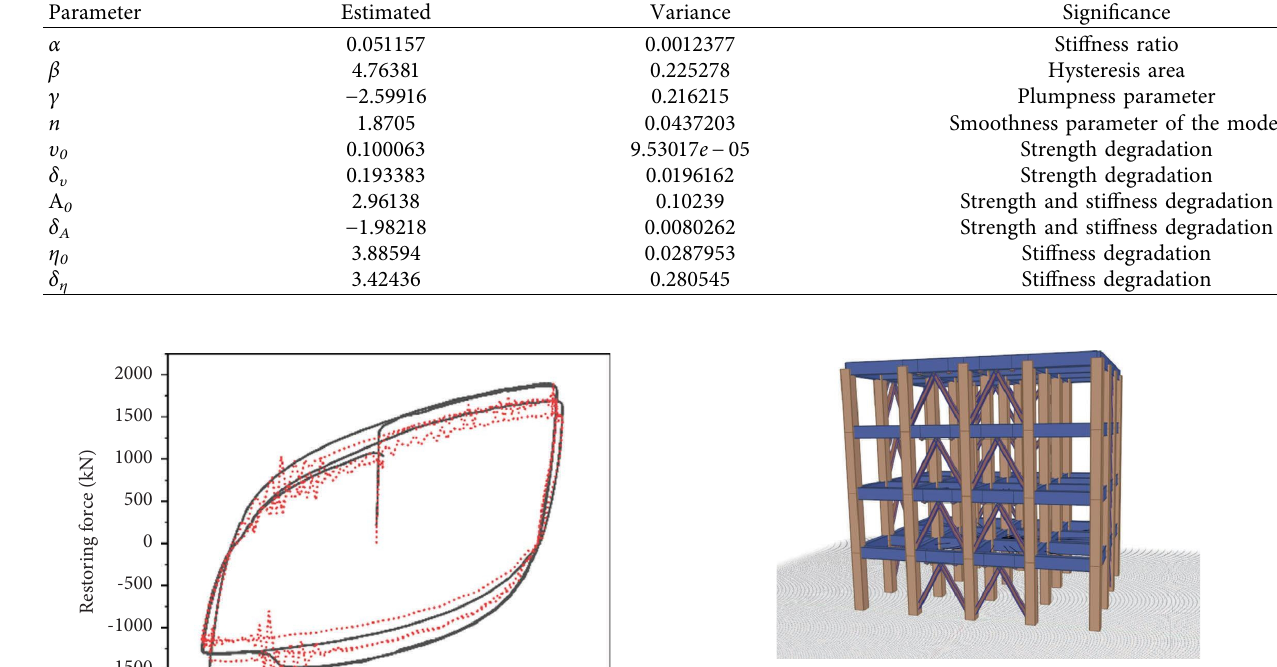
Figure 10: Model diagram.